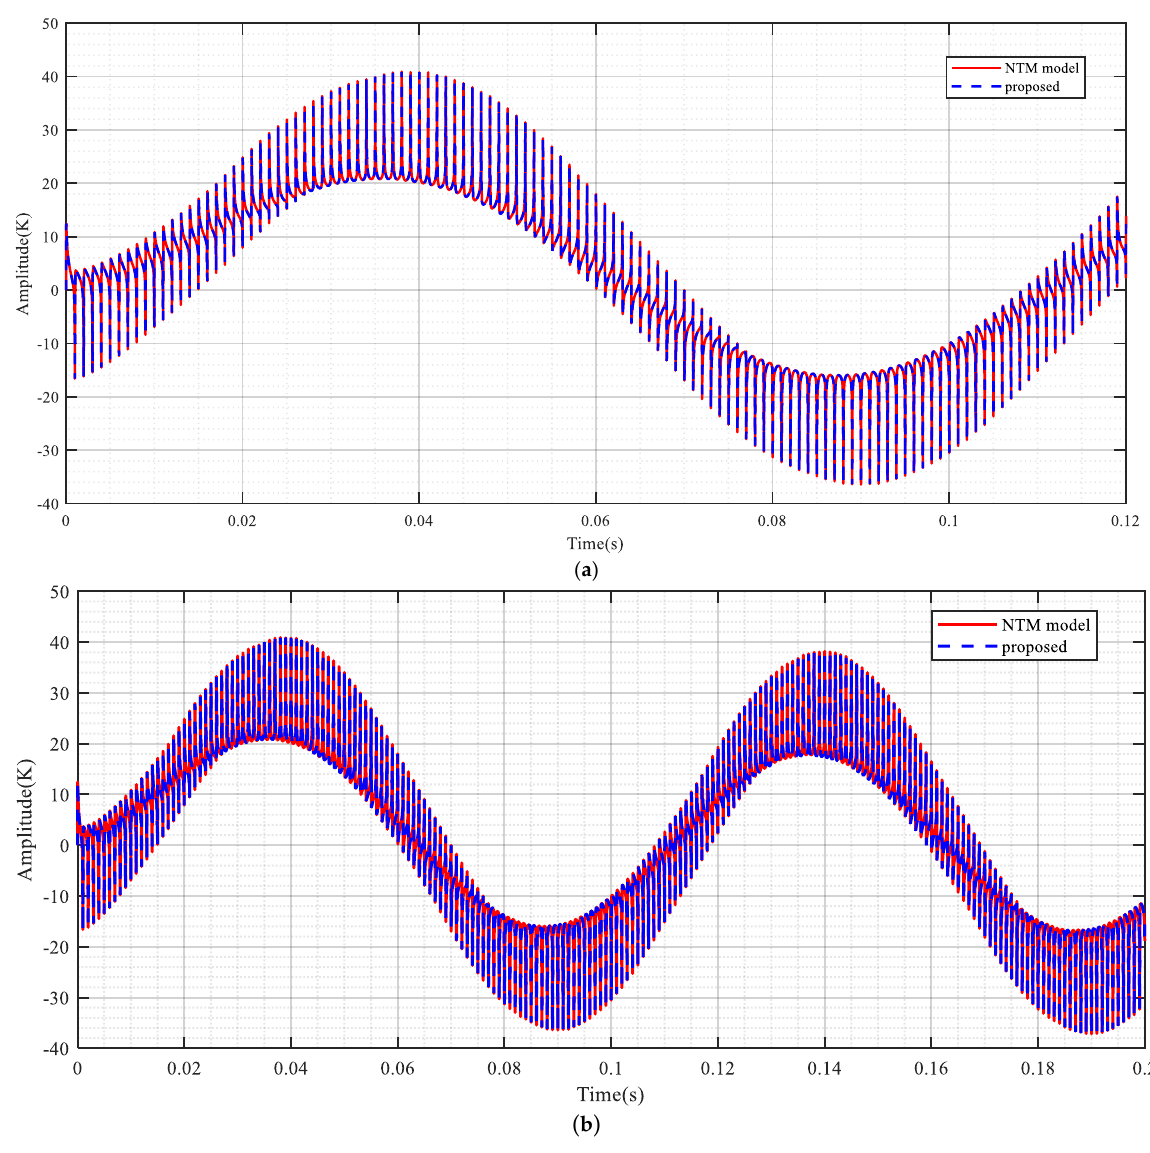
Figure 4. Time-domain transient response on point 1. ( a ) Zoom in (0-0.12 s). ( b ) Whole excitation duration (0-0.2 s).